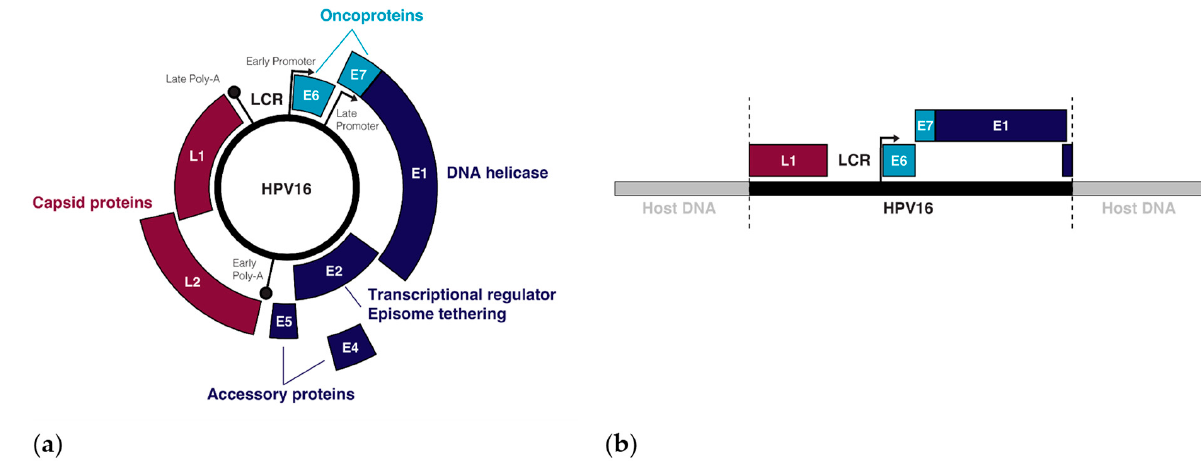
Figure 1. The episomal and integrated forms of the HPV genome: ( a ) The genes and regulatory regions in the HPV16 episome; ( b ) An example of the integrated form of HPV16 with breakpoints in the L1 and E2 genes.